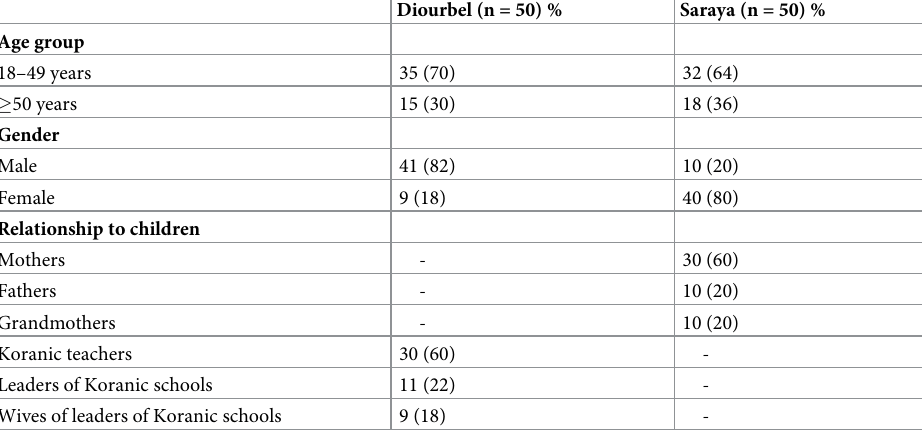
Table 1. Socio-demographic characteristics of study participants, Diourbel and Saraya,